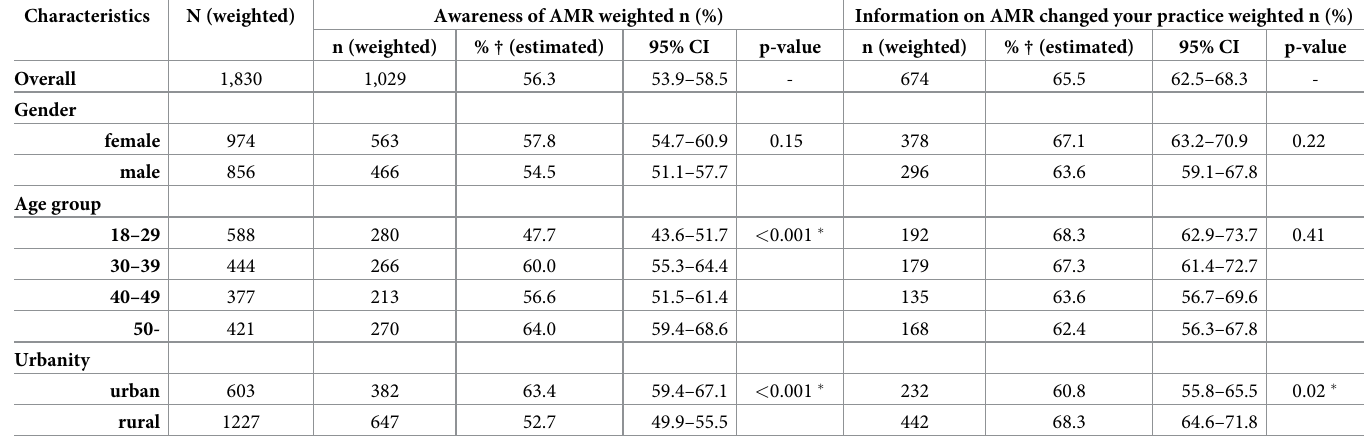
Table 5. Awareness of antimicrobial resistance (AMR) (N = 1,830).